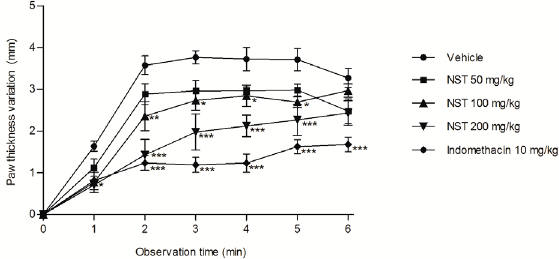
Figure 2 - Effect of the NST (50, 100 e 200 mg/kg, i.p.), vehicle (NaCl 0.9% + 5% Tween 80), and indomethacin (10